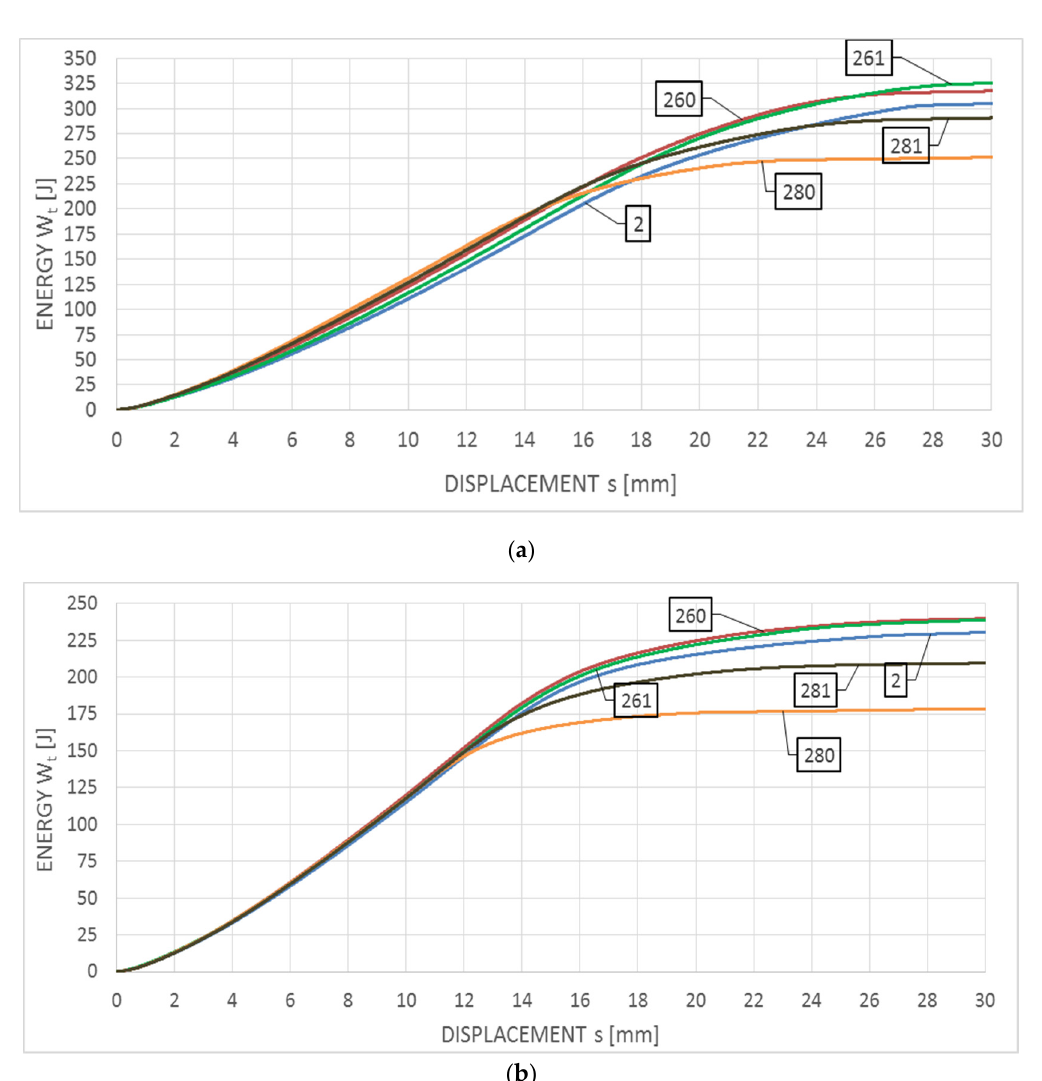
Figure 10. Averaged 𝐹 − 𝑠 curves obtained on samples made of 1H18N9T steel: ( a ) during tests conducted in +20 °C, ( b ) during tests conducted in − 20 °C.